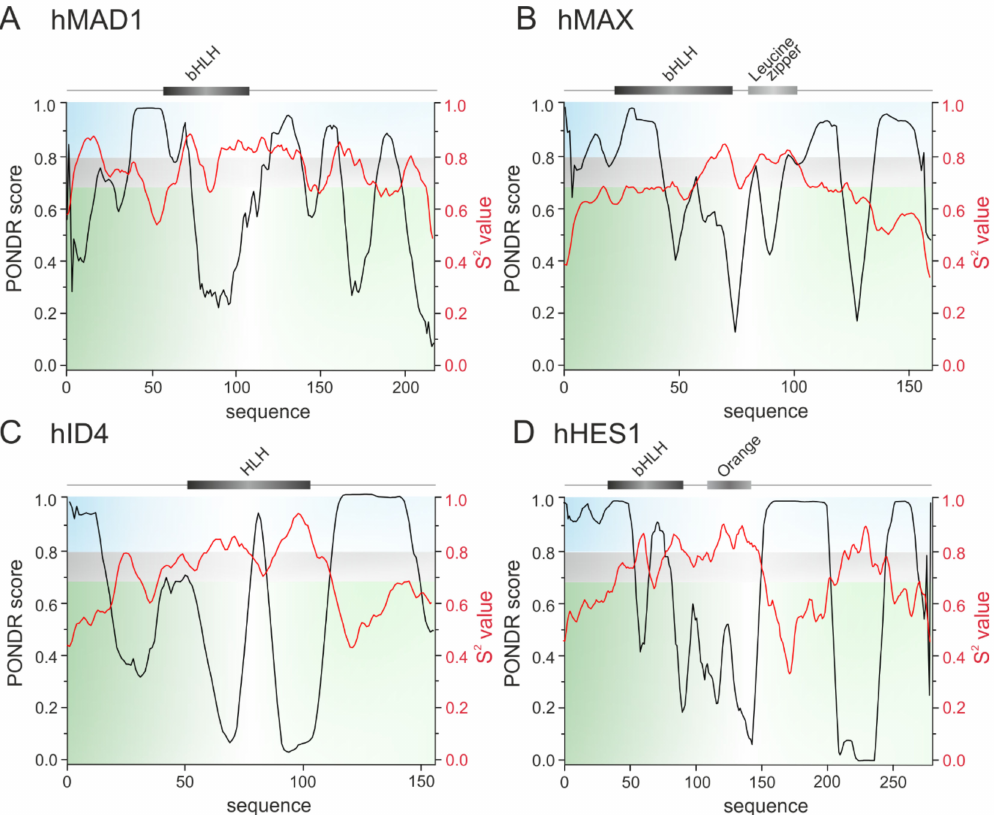
Figure 2. Prediction of intrinsically disordered regions. The top panel presents the domain structure of the analyzed bHLH proteins. Dark grey rectangle indicates the bHLH domain, light grey indicates Leucine zipper or Orange domain. The bottom panel presents a prediction of intrinsically disordered and flexible regions, based on the amino acid sequence of proteins. Predictions were performed using PONDR-VLXT (left Y axis) and DynaMine (right Y axis) software. For PONDR prediction, a score above 0.5 indicates disorder. For Dynamine, a S 2 value above 0.8 (blue zone) indicates rigid conformation, 0.69–0.8 (grey zone) is context dependent and a value below 0.69 (green zone) indicates flexible conformation. ( A ) class IV human MAD [Q9Y6D9] and ( B ) human MAX [P61244], ( C ) class V human ID4 [P47928], ( D ) class VI human HES1